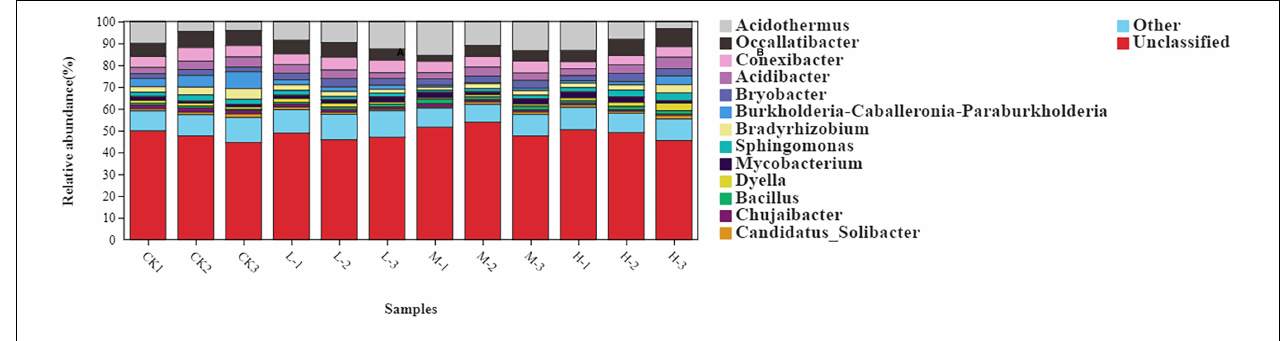
FIGURE 4 | Relative abundance of major bacterial genus under four different nitrogen application.